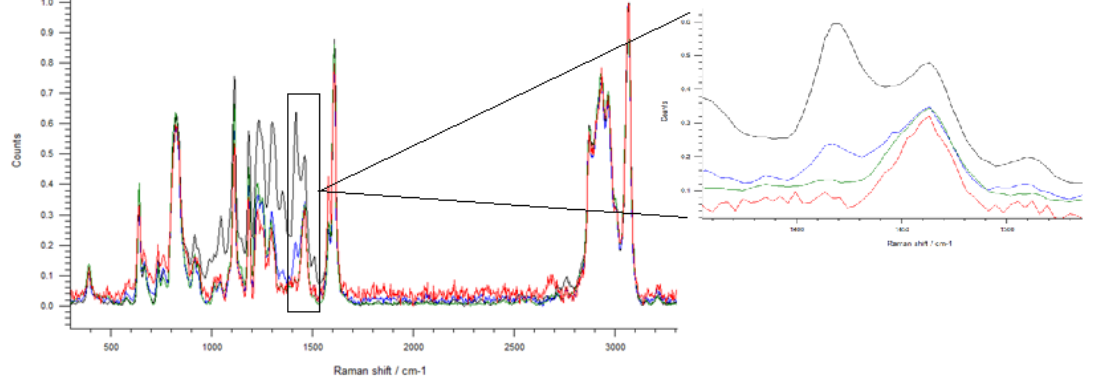
Figure 20. Comparison of Raman Spectrum after 31 days in sulfuric acid of resin and composites .